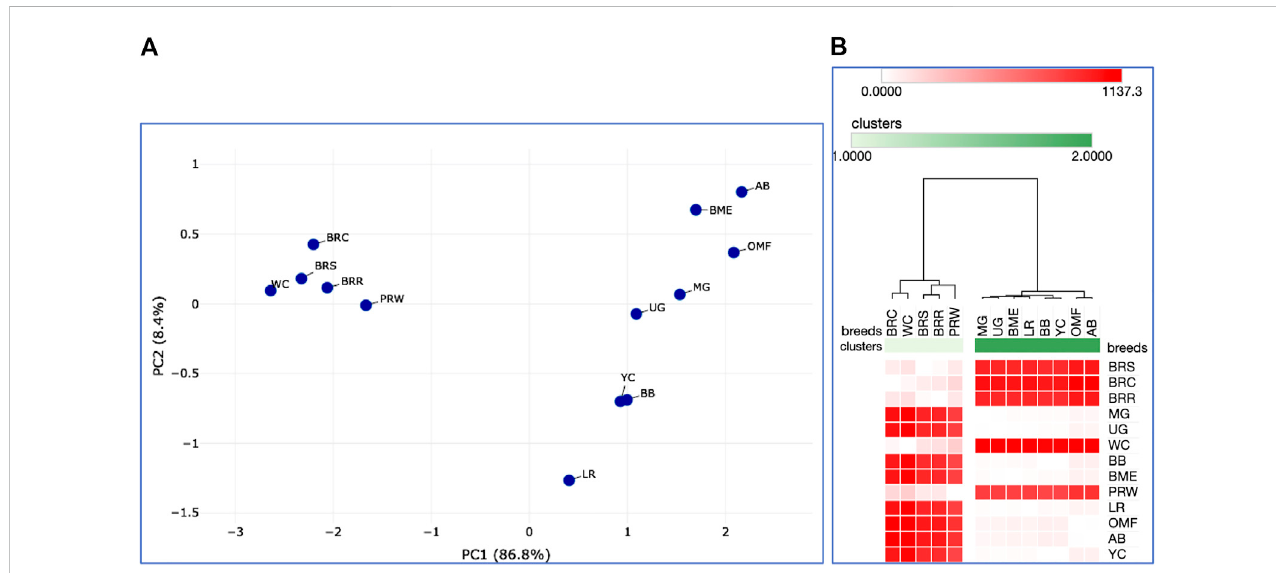
FIGURE 6 Analysis of the distribution of 13 breeds by early growth traits, including EW and BW of chicks at three ages, as generated in the Phantasus program (Zenkova et al., 2018). (A) PCA plot. X and Y -axes show principal component 1 (PC1) and principal component 2 (PC2) that explain 86.8% and 8.4% of the total variance, respectively. N = 13 data points (breeds). (B) Heatmap and hierarchical clustering tree using Euclidean distance-based similarity matrix. For clustering, matrix values (for a precomputed distance matrix) were applied as metrics (with the average linkage method option